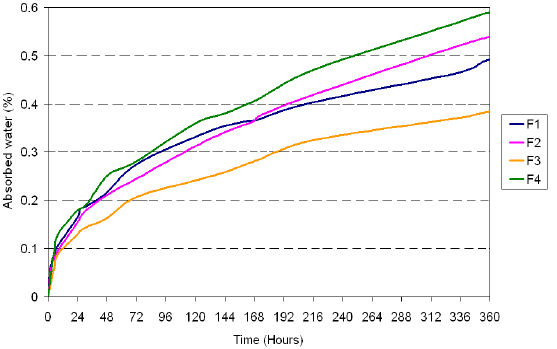
Figure 7. Absorbed water after immersion at ambient temperature.